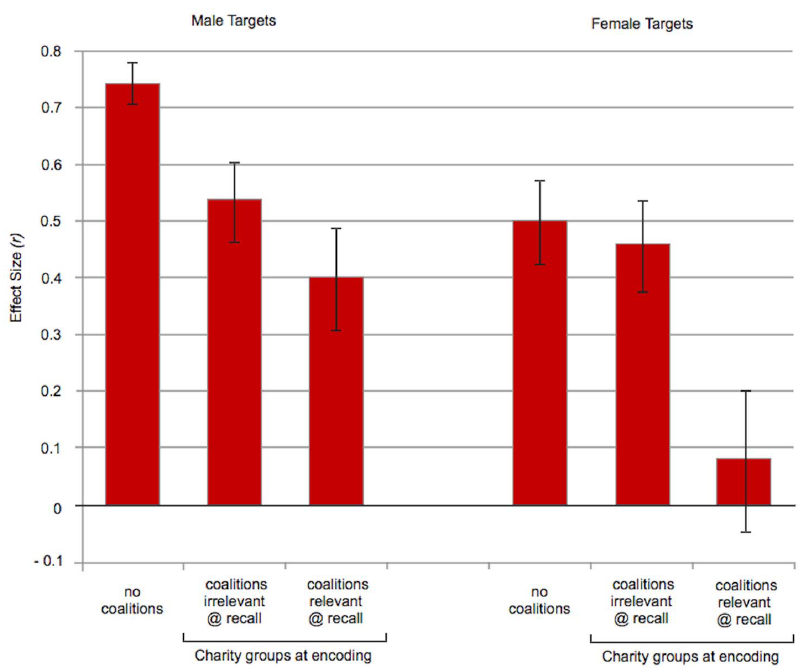
Figure 4. Coalitional variables regulate racial categorization (Studies 1 and 3). All targets wore gray shirts in these conditions; the only cues to charity group membership were behavioral. Effect sizes for racial categorization are shown for male targets (left panel) and female targets (right panel). In each panel, the leftmost bar (labeled ‘‘no coalitions’’) depicts racial categorization when coalitions were absent (Study 1). The two bars to its right depict racial categorization when coalitions were present and crossed with race (Study 3). Behavioral cues to coalition membership were present at encoding for all the coalition conditions of Study 3. The sentences at recall varied across conditions: Their content was either relevant to coalition membership (‘‘coalitions relevant @ recall’’) or applicable to members of both coalitions (‘‘coalitions irrelevant @ recall’’). Retrieval of racial categories was down-regulated most strongly when the recall context included behavioral cues that coalition membership was relevant to the targets—the same recall contexts that up-regulated the retrieval of charity group membership. Indeed, race was ‘‘erased’’ (not retrieved to a significant extent) for female targets in this condition. Error bars: + / 2 1 S.E.